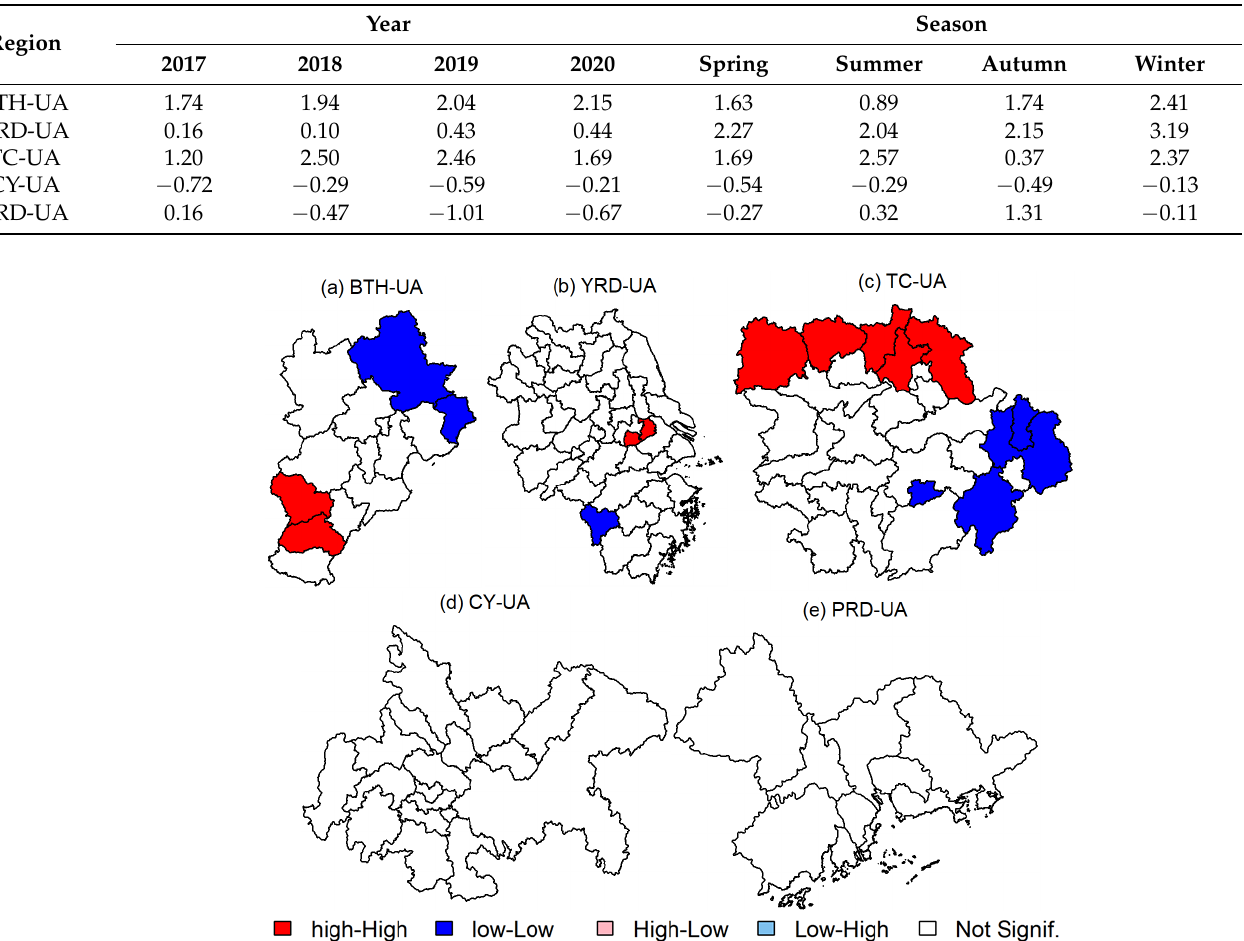
Figure 7. Spatial agglomeration of MDA8 O 3 concentrations in five urban agglomerations in 2017 – 2020.